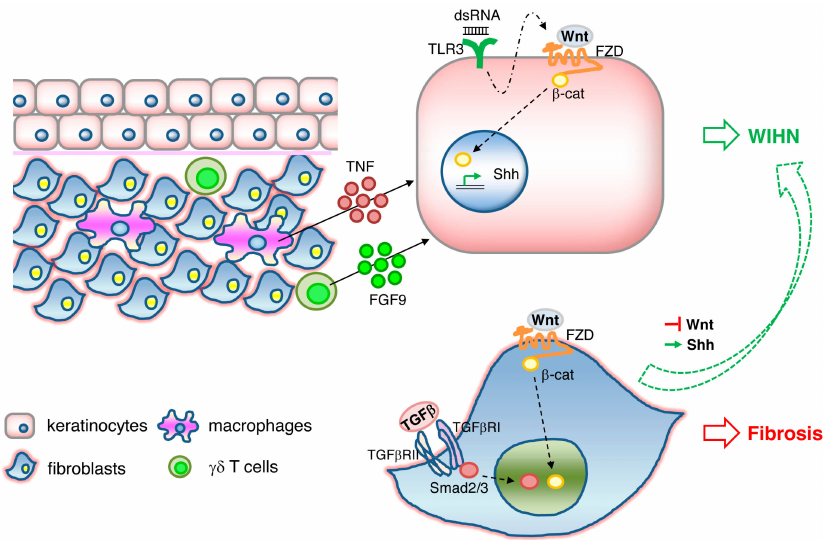
Figure 1. Signaling pathways involved in wound-induced hair follicle neogenesis (WIHN). Wnt / β -catenin signaling and downstream Shh signaling in keratinocytes activates WIHN. TNF released from macrophages, FGF9 released from γδ T cells, and double-strand RNA binding to TLR3 in keratinocytes induces WIHN. Wnt // β -catenin and TGF β / Smad signaling in fibroblasts results in fibrosis. Activation of Shh or suppression of Wnt pathways in fibrosis is su ffi cient to redirect Wnt-active wound fibroblasts to